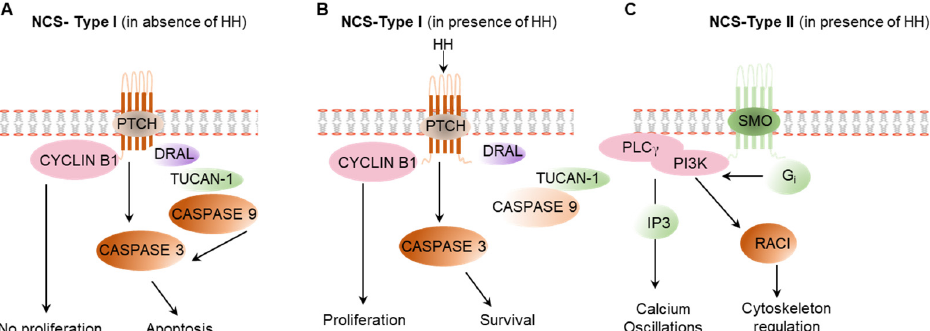
Figure 5. Non-canonical hedgehog signaling pathways. ( A ) In the absence of HH ligand, PTCH forms a complex with CYCLIN B1, DRAL, TUCAN-1, and CASPASE 9 that activates CASPASE 3, which induces apoptosis. In the absence of HH ligand, CYCLIN B1 remain inactive in the proteome complex and do not induce cell proliferation. ( B ) In presence of HH ligand, PTCH breaks the interaction with CYCLIN B1, DRAL, and CASPASE 9 and CASPASE 3, which activate the cell proliferation. CASPASE 3 is not be activated, which results in cell survival. ( C ) HH-activated SMO causes the dissociation of Gi, which activate PI3 kinase, which results in the regulation of cytoskeleton and calcium signaling. NCS: non cannonical signaling of HH.